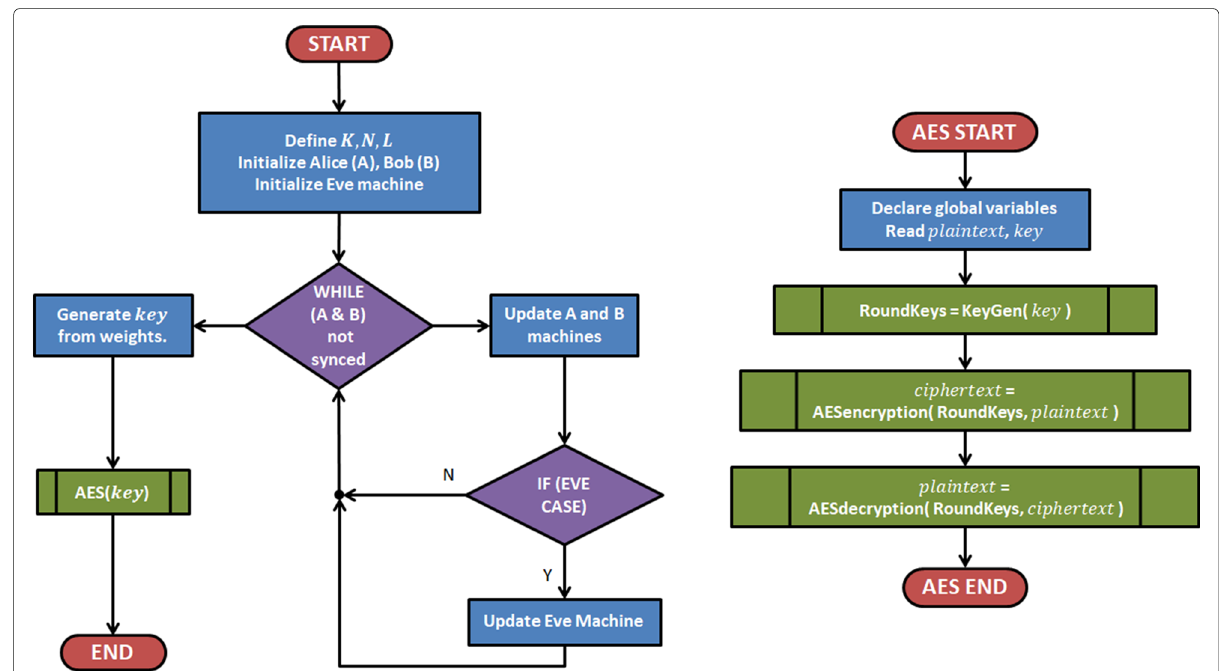
Fig. 3 Virtual model flowchart. The flowchart described how the performance metrics and security evaluation is performed on the